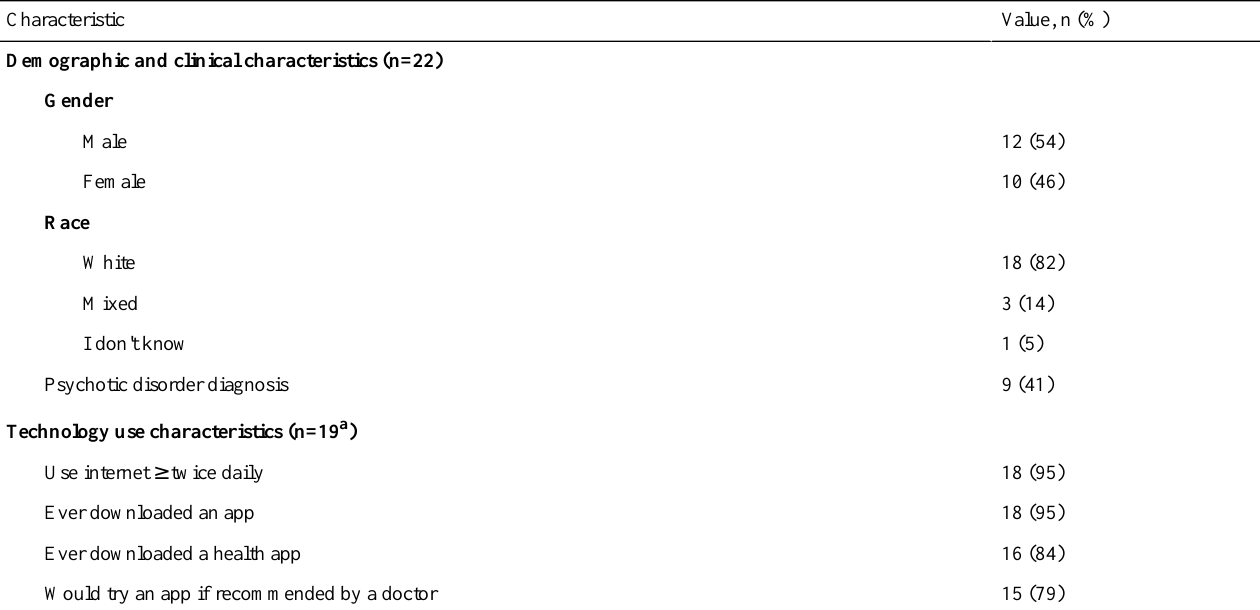
Table 1. Focus group participant